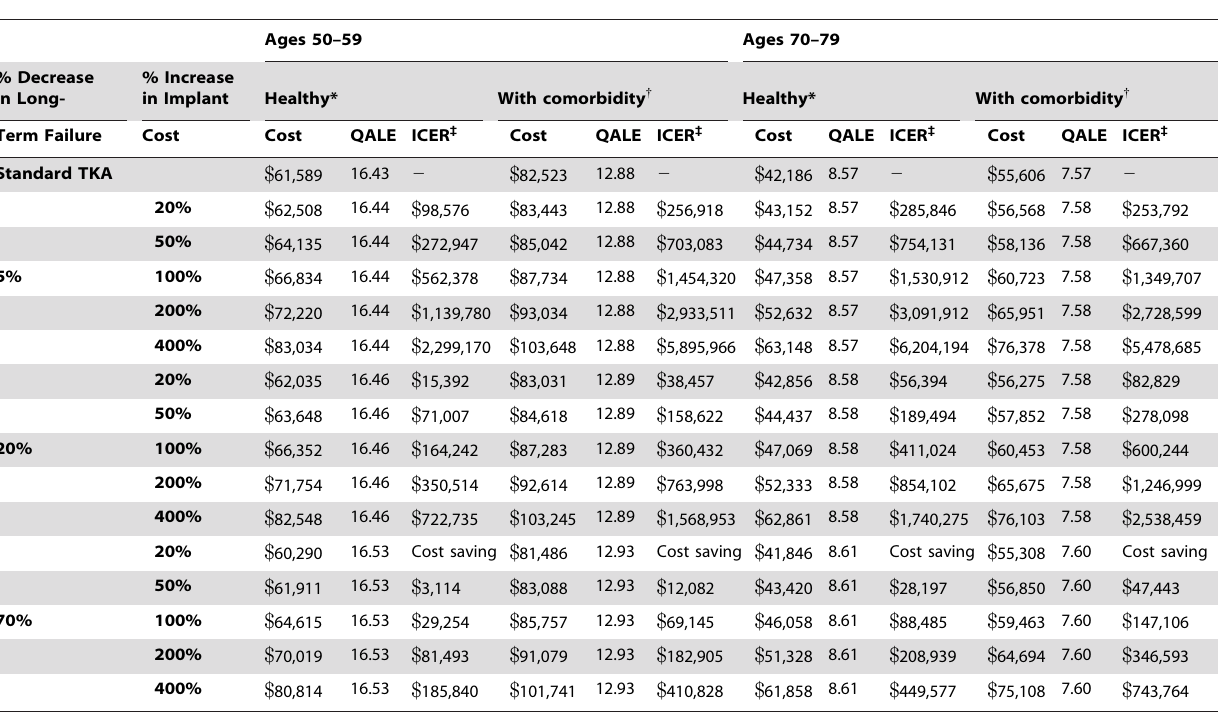
Table 2. Lifetime QALE, cost, and cost-effectiveness estimates associated with Standard and Innovative